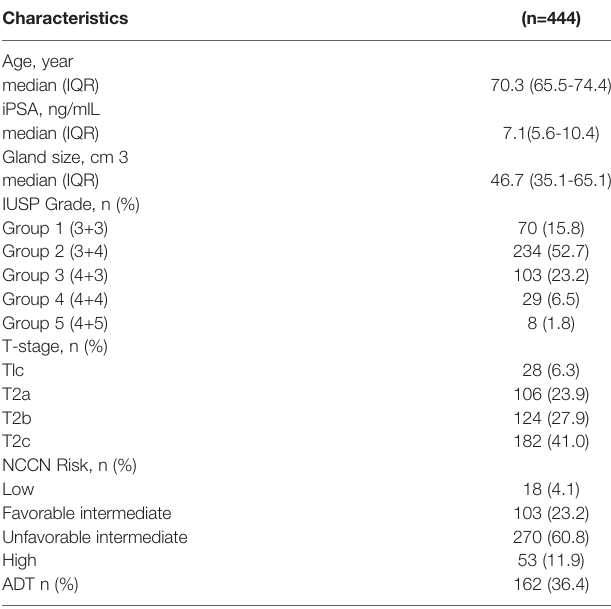
TABLE 1 | Patient and tumor